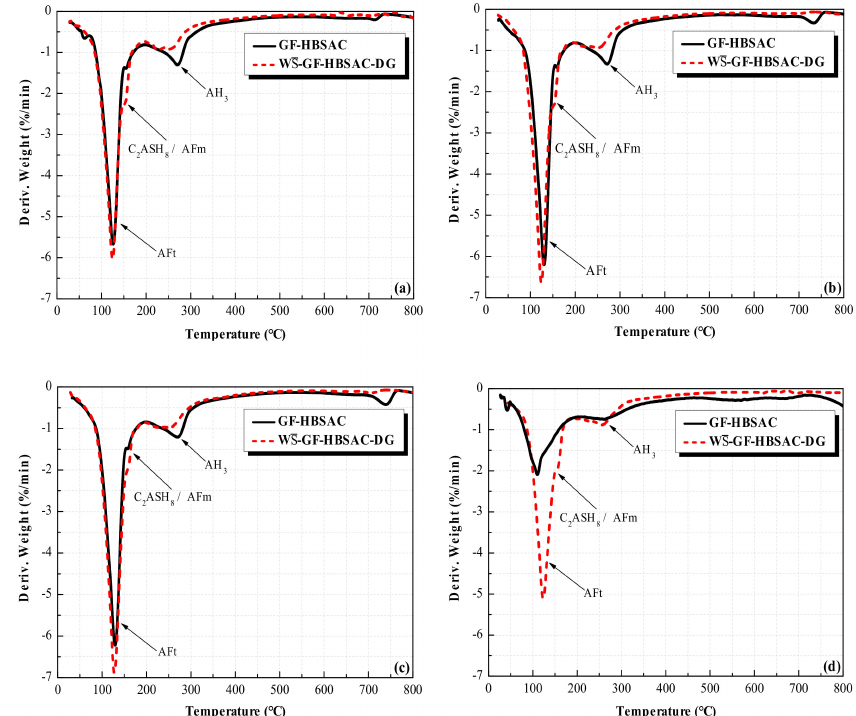
Figure 16. DTG curves of the Series GF-HBSAC-X cement hydration products at di ff erent curing ages: ( a ) One day; ( b ) 3 days; ( c ) 7 days; ( d ) 28